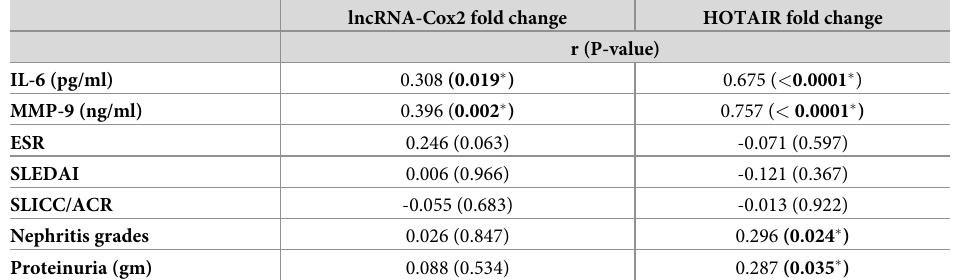
Table 3. Correlation between serum expression levels of lncRNA-Cox2 and HOTAIR and other laboratory char- acteristics in systemic lupus erythematosus (SLE) patients.